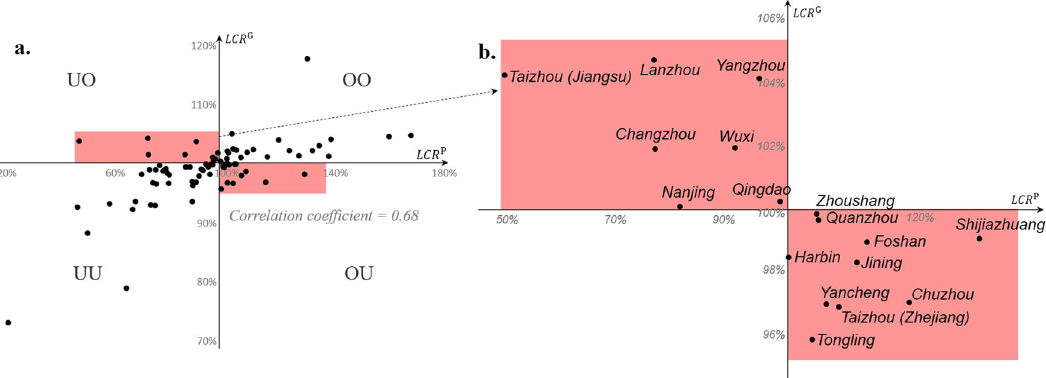
Fig. 4 Distribution of cities in LCR feature space. a Points represent the 81 cities in the LCR feature space, x-axis shows LCR for population ( LCR P ), and y-axis is LCR for GDP ( LCR G ). UO means underload population but overload GDP, while OU means the opposite; OO denotes overload for both, while UU is underload for both. b A close-up view of cities distributed in the UO and OU quadrants with city names, LCR P , and LCR G